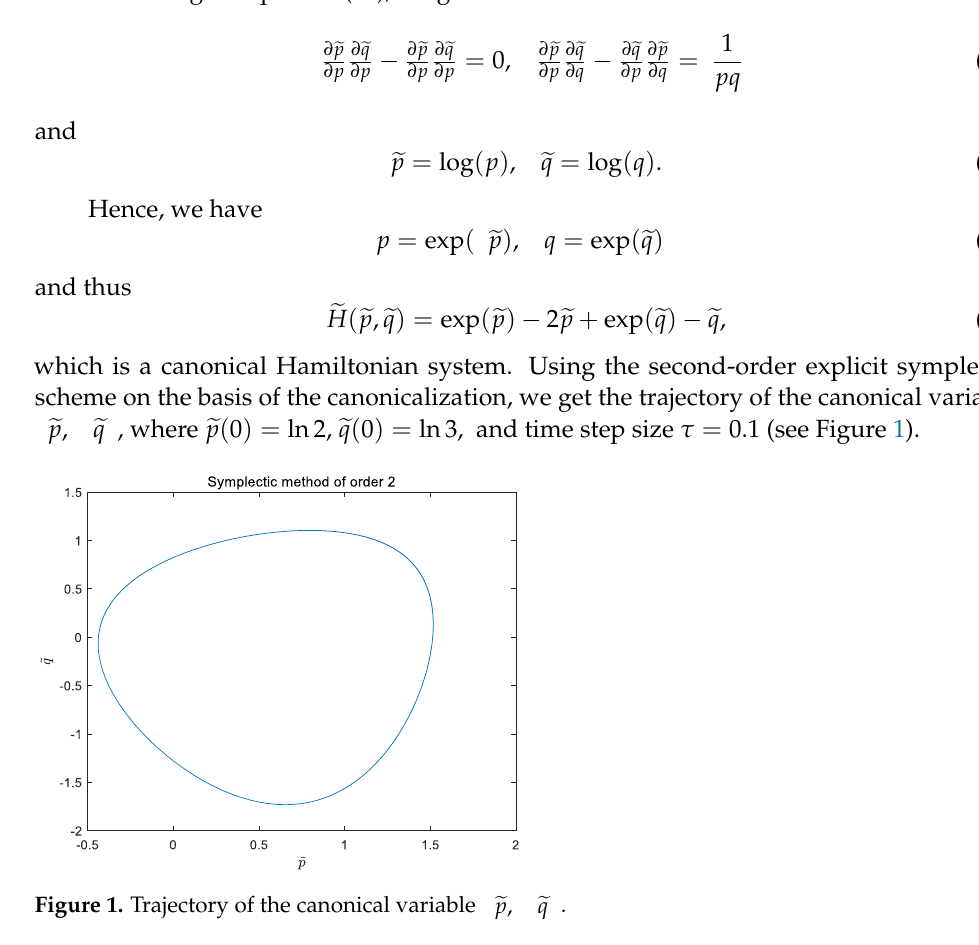
Figure 3. Trajectory of the non-canonical variable. As can be seen from Figures 1 and 2, the trajectory diagrams of regularized variables and initial variables are kept unchanged by a symplectic algorithm. After 1,000,000 steps, the graph remains basically unchanged, which indicates that the symplectic algorithm of constrained Hamiltonian systems has the property of preserving structure. Namely, the physical properties of constrained Hamiltonian systems can be maintained by a symplec- tic method. One can see from Figure 3 that the graph using the third-order Runge Kutta method (or general numerical calculation method) is very unstable. This method does not have the property of preserving the structure, that is, it cannot maintain the physical prop- erties of the constrained Hamiltonian systems. It is shown clearly from the three figures that the symplectic algorithm has better structure-preserving properties. It is of great sig- nificance to study the constrained Hamiltonian systems using the symplectic algorithm. 5. Conclusions In this paper, we discuss the canonicalization method of the constrained Hamiltonian systems, then the symplectic method is applied to the constrained Hamiltonian systems